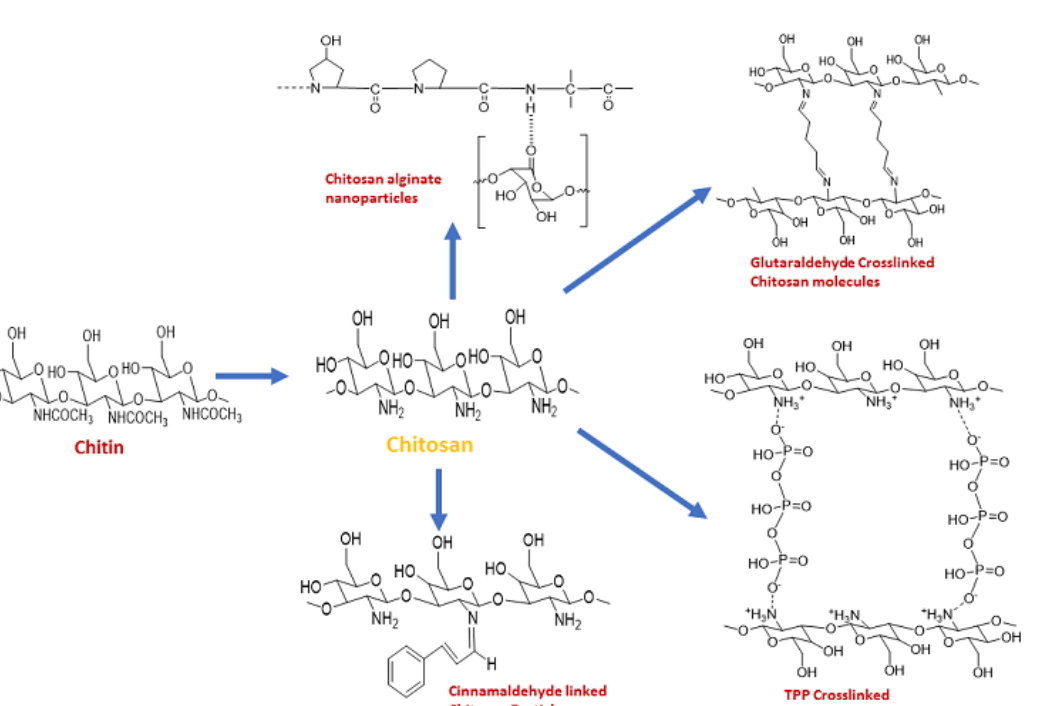
Figure 3. Applications of chitosan-based materials.